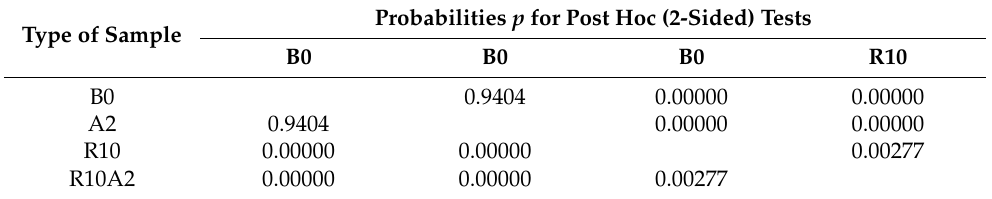
Table 5. p -values of Scheff é post hoc tests for independent samples.